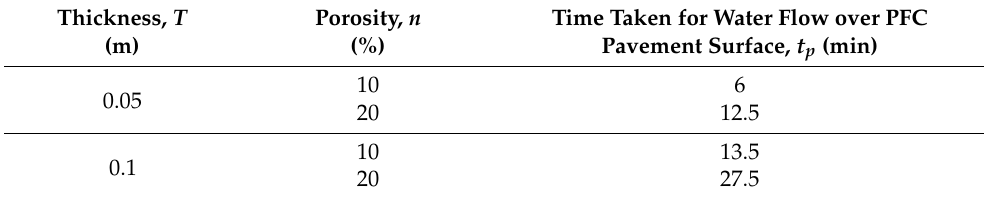
Table 6. Time taken for water flow over the PFC pavement surface ( t p ) for I = 100 mm/h, L R = 10 m, and S R = Table 5. Time taken for water flow over the PFC pavement surface ( t p ) for I = 50 mm/h, L R = 10 m, and S R = 2%.